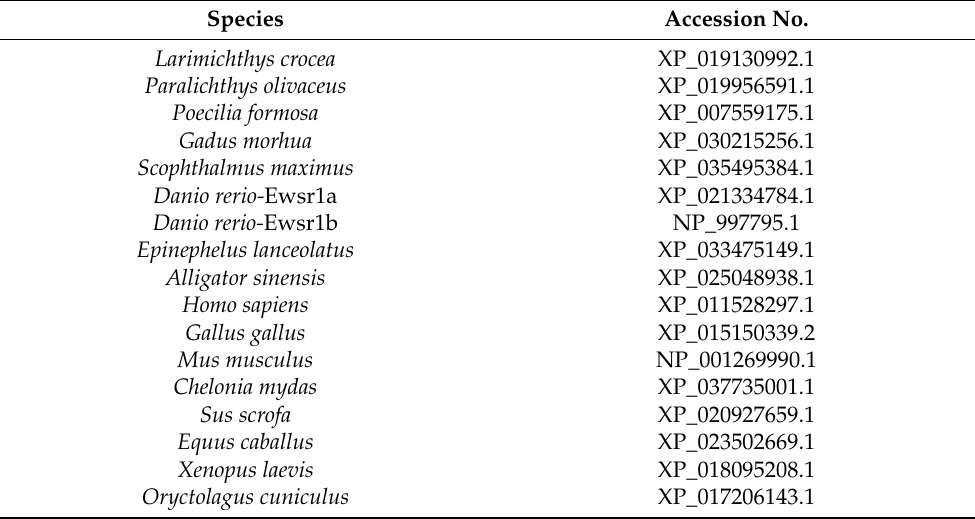
Table 2. Accession numbers of Ewsr1 proteins used in this